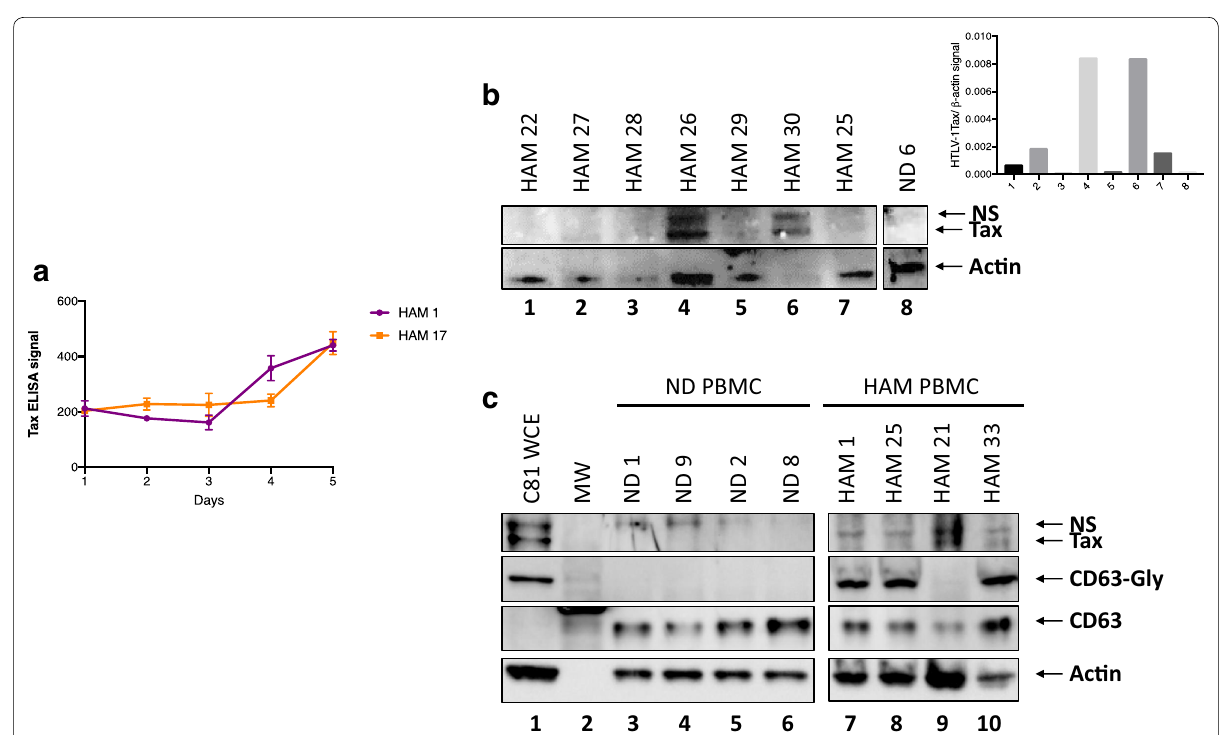
Fig. 4 Cultured HAM/TSP PBMCs produce exosomes containing HTLV‑1 Tax. a HAM 1 and HAM 17 PBMCs were cultured over 5 days and were assessed for HTLV‑1 Tax content from isolated exosomes by electrochemical ELISA. b A representative Western blot of HTLV‑1 Tax and Actin from nanotrapped (NT80 82) exosomes of 7 HAM/TSP patient PBMCs after 5 days culture. Tax compared to Actin (β‑actin) levels was quantified for the + Western blot and shown in the upper right insert. NS nonspecific band. c An additional Western blot of HTLV‑1 Tax, CD63 (two forms: glycosylated (CD63‑Gly) and unmodified), and Actin from nanotrapped (NT80 82) exosomes of 4 ND and 4 HAM/TSP patient PBMCs after 5 days culture was + performed. ND PBMCs were cultured with 100 IU/mL IL‑2 while HAM/TSP PBMCs received no exogenous cytokines. Samples were run on a 4–20% Tris–glycine gel, followed by overnight wet transfer to PVDF membranes. C81 whole cell extract (WCE) was utilized as Tax positive control. NS nonspecific band, MW molecular weight